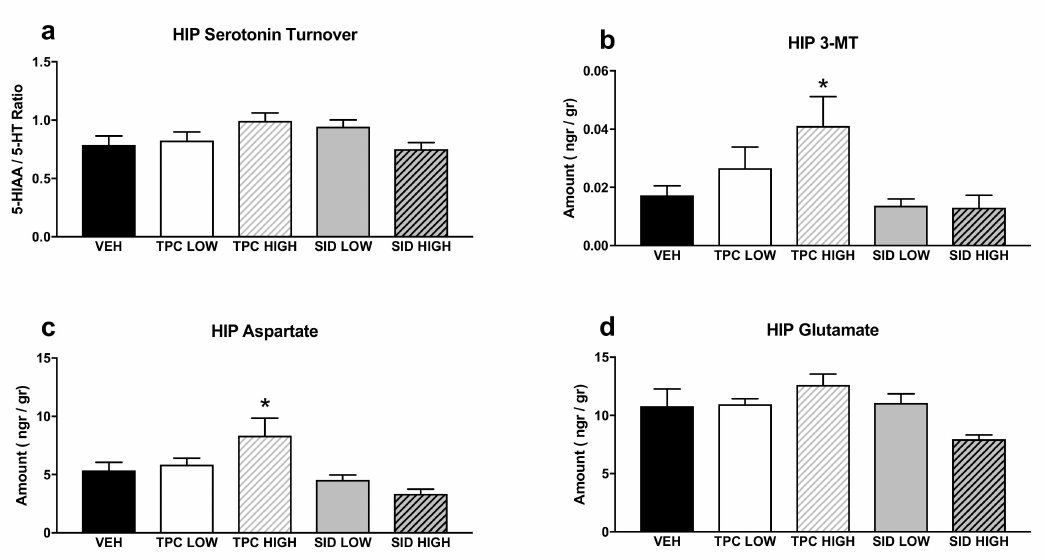
Figure 4. Aminoacids and monoamines in the hippocampus (HIP). ( a ) Serotonin turnover rate, calculated as the 5-HIAA / 5-HT ratio; ( b ) 3-MT tissue levels; ( c ) aspartate tissue levels; ( d ) glutamate tissue levels. TPC Low Dose = 10 mg / kg, High Dose = 30 mg / kg, SID Low Dose = 50 mg / kg, High Dose = 150 mg / kg. N = 7–9 / group. An asterisk denotes a significant di ff erence between a treatment group and the corresponding vehicle-treated control